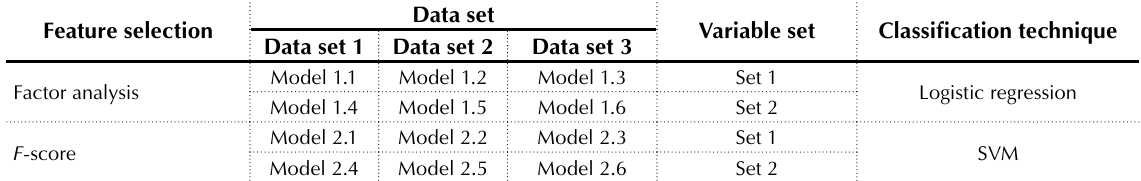
Table 1. Description of the